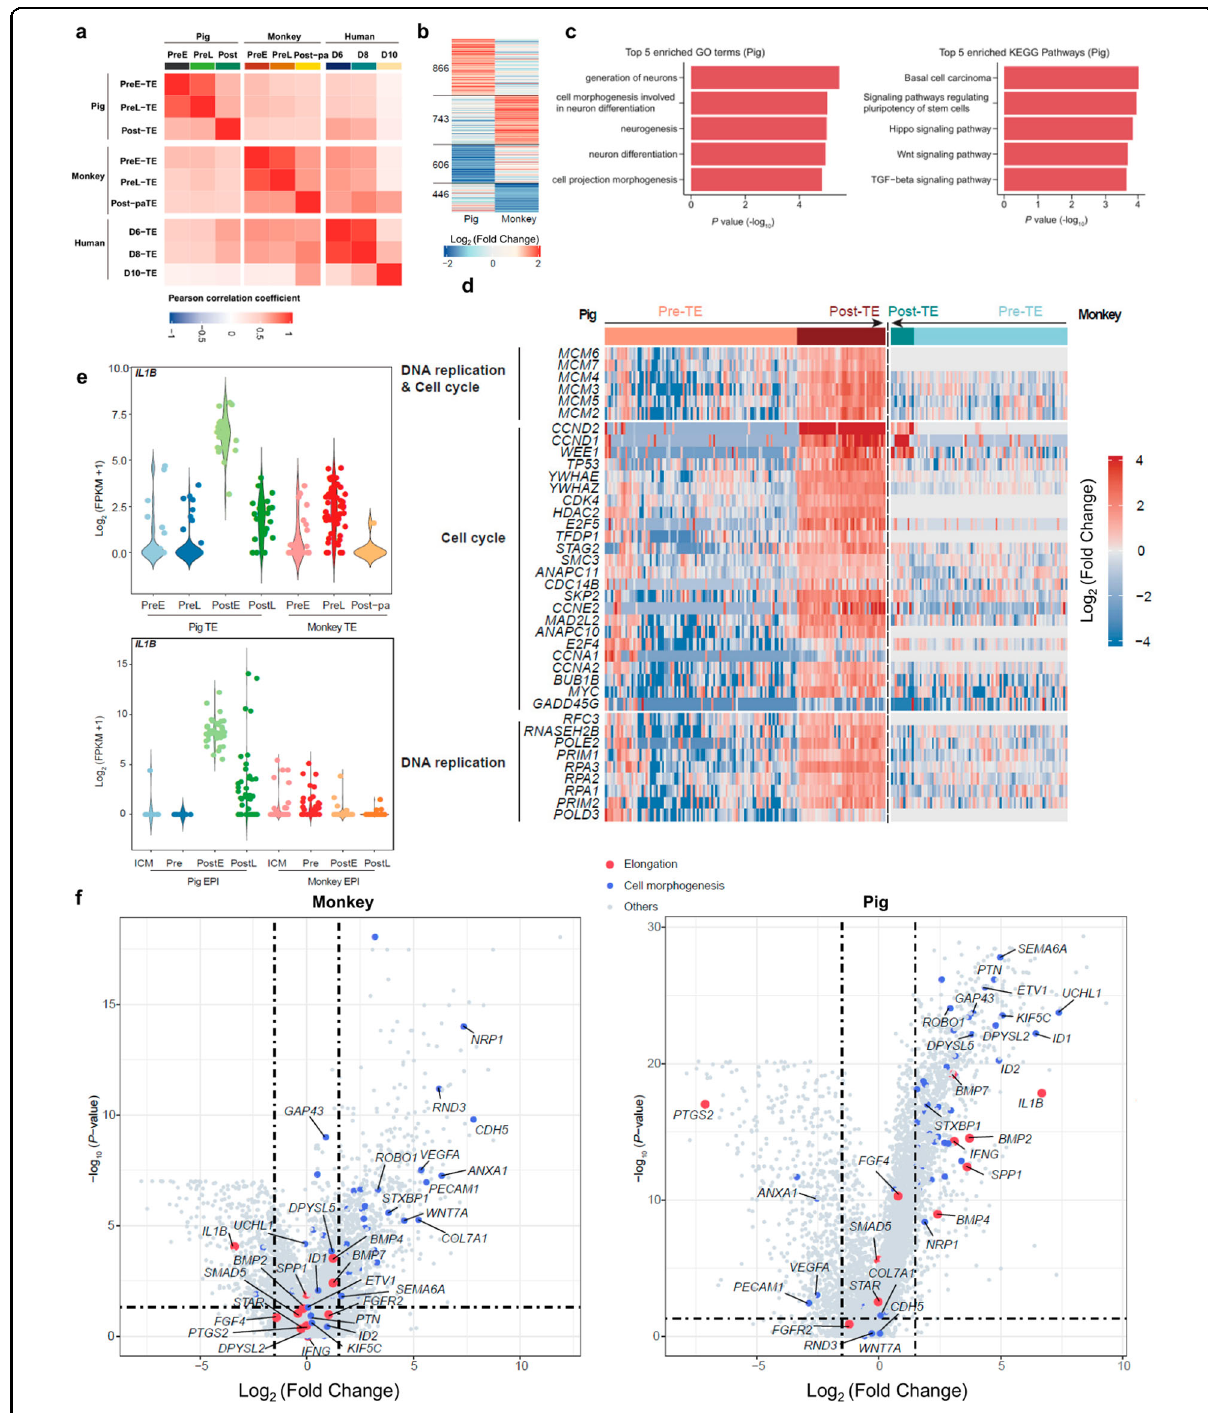
Fig. 6 Cross-species comparison of TE development. a Heatmap of the correlation coef fi cients among TEs in pig, human, and monkey. b Heatmap of DEGs of Pre- and PostE-TEs in pigs and monkeys. c Top 5 enriched GO terms and KEGG pathways of upregulated DEGs in pig Pre- and PostE-TEs. d Heatmap of fold change of cell cycle- and DNA replication-related genes in Pre- and Post-TEs of pigs and monkeys. e Violin plots of the expression of IL1B in pig and monkey EPIs and TEs from different stages. f Volcano plot showing DEGs between Pre- and Post-TEs of monkey and pig, respectively. Elongation- and cell morphogenesis-related genes are shown in red and blue, respectively; others are shown in gray. Stage information was indicated as follows: Pre-, Day 5 or/and Day 7; PreE-, Day 5; PreL-, Day 7; Post-, Day 10 and Day 12; PostE-, Day 10; PostL-, Day